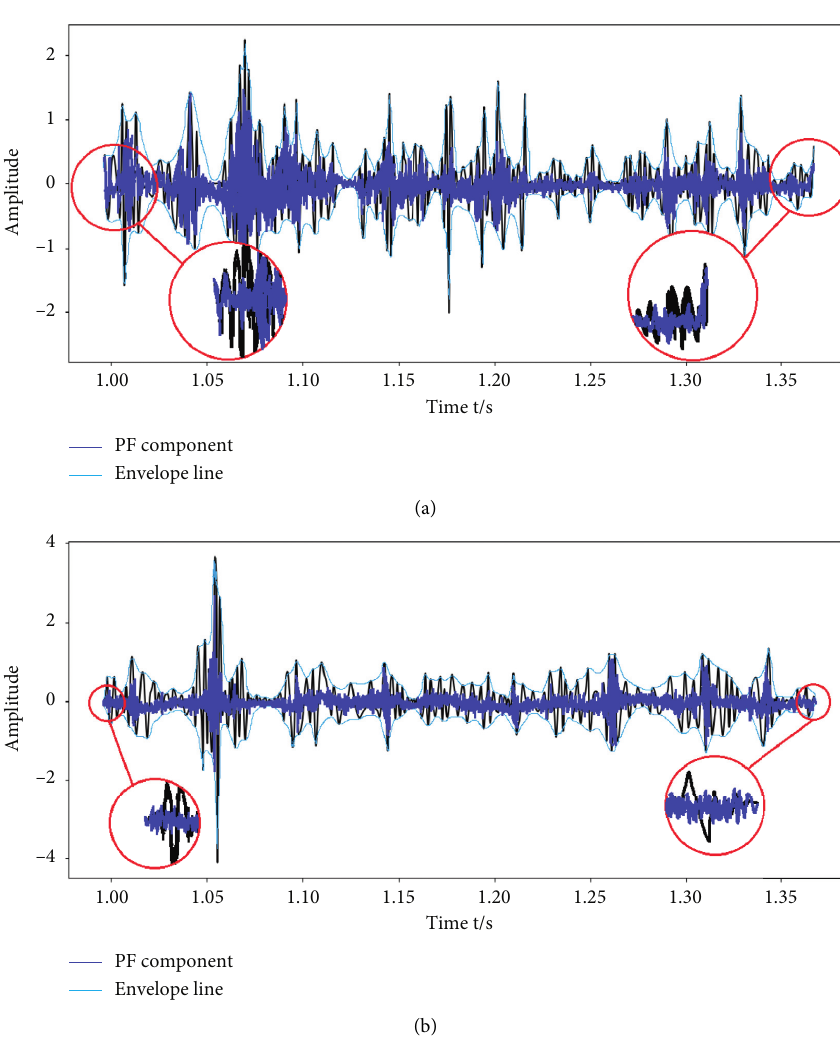
Figure 3: The first PF component and the original vibration